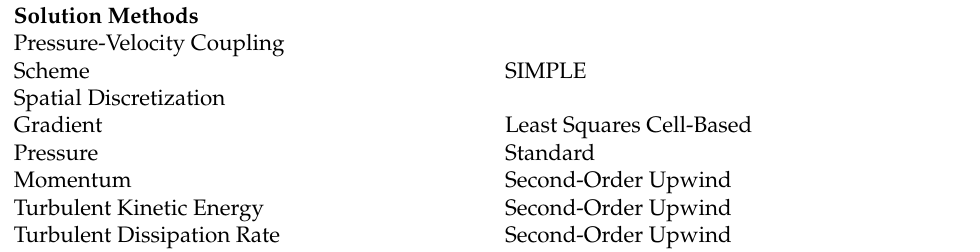
x ) between CFD and